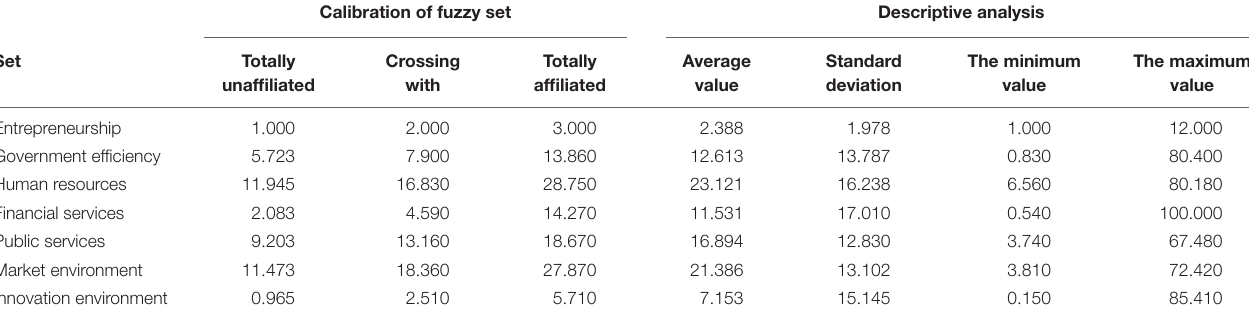
TABLE 4 | Set, calibration and descriptive statistics.